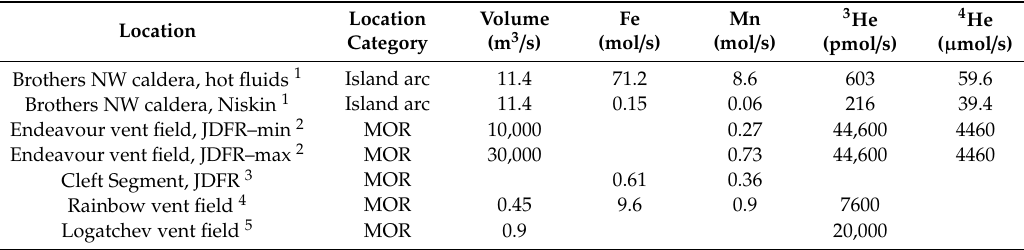
Table 7. Comparison between hydrothermal discharge estimates published in the literature and results from Brothers volcano (end member and Niskin estimates taken from Table 5). If ranges were given in the references, min and max values are included in the table. JDFR: Juan de Fuca Ridge, MOR: mid ocean ridge. The data from Okinawa Trough is originally published as sum of 15 vents, we here list 1 / 15 of the sum as the individual vent contribution for a better comparability. Data: 1 data